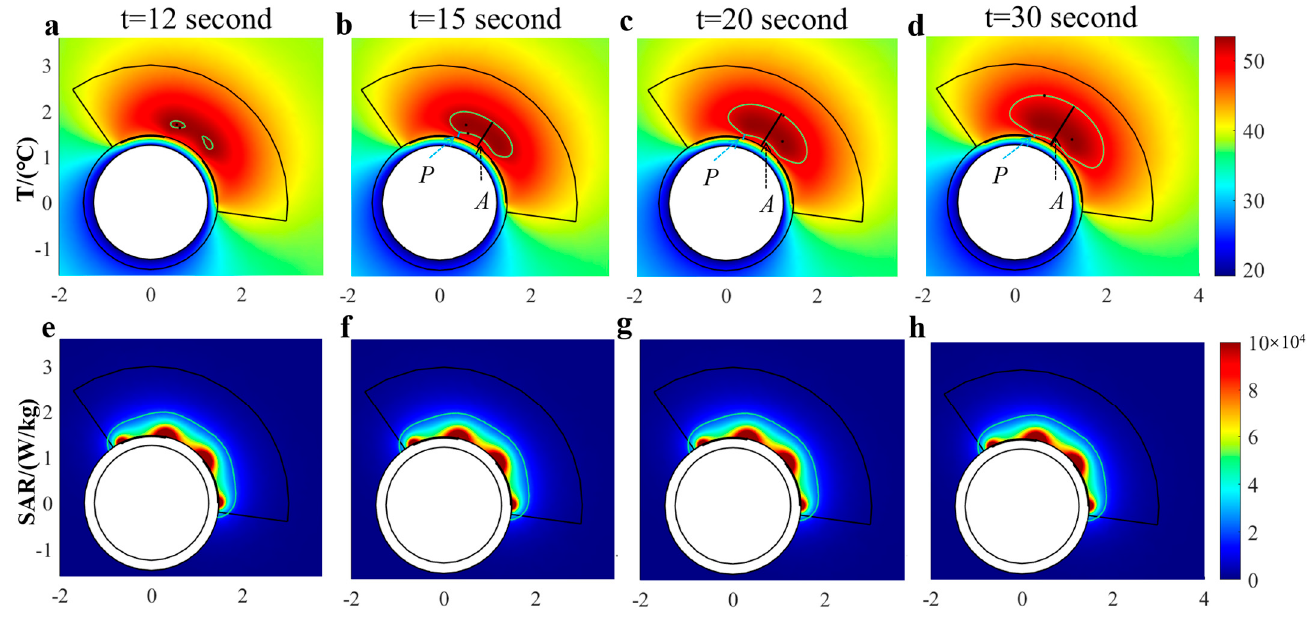
Figure 6. ( a – d ) Evolution of the ablation zone and ( e – h ) SAR distribution during the heating process ( T target = 35 °C, T f = 18.5 °C, V f = 2 m/s, and h = 9303 W/(m 2 *K)). Ablation depth ( A ) and protection depth ( P ) are marked in ( b ).